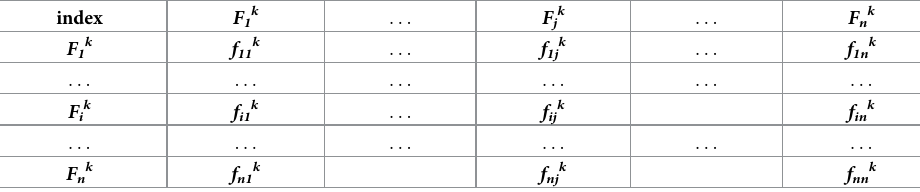
In Table 2, h is the total number of evaluators; k denotes the k th evaluator; n is the total number of indicators in the criteria layer; F ik and F jk are the i th and j th indicators of the k th evaluator in the criteria layer, respectively; and f ijk is the importance of indicator F ik compared with indicator F jk . The value is determined according to the (1/9, 9) scale method by each